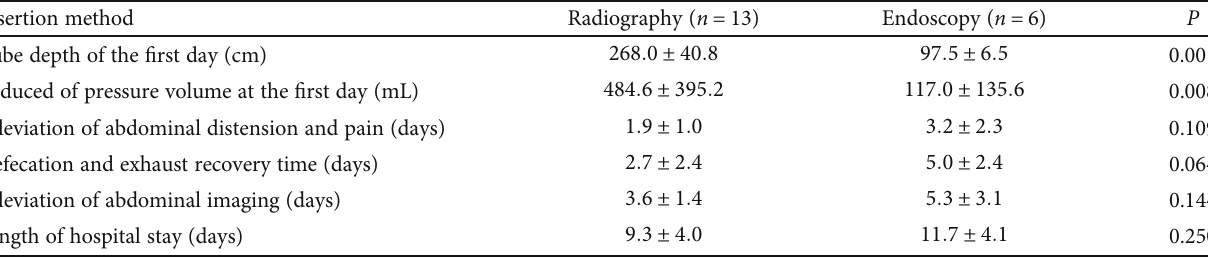
Table 2: Comparison of the insertion methods of the transnasal ileus tube.